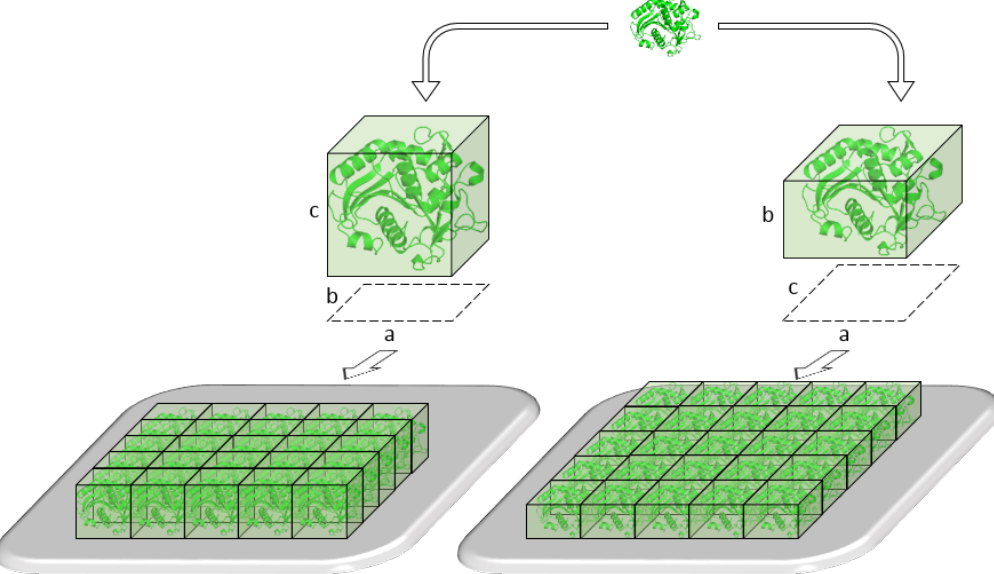
Figure 6. Visualization of the theoretical orientation and distribution of a lipase molecule on the BT surface. Assuming a cuboid morphology, lipase can theoretically attach to the BT surface with its smallest (area a × b) or largest (area a × c) cuboid area. After complete coverage of the carrier surface with enzyme, a minimum and maximum of lipase molecules per BT surface can be calculated and represent a range of theoretical surface-specific enzyme mass. In comparison, the real orientation of the lipase molecules on the BT surface is assumed as a random process. Furthermore, real coverage can take place in three states: (I) below the theoretical minimum, representing incomplete BT surface coverage, (II) above the theoretical maximum, representing an enzyme multilayer or enzyme aggregate formation, and (III) within the theoretical minimum and maximum, when immobilized enzyme mass is in this range, but enzyme aggregates exist with free space between. However, comparing the theoretical and measured states allows an assessment of utilizing the available BT surface for enzyme immobilization. The 3D model of lipase was taken from the RCSB Protein Data Base (ID code: